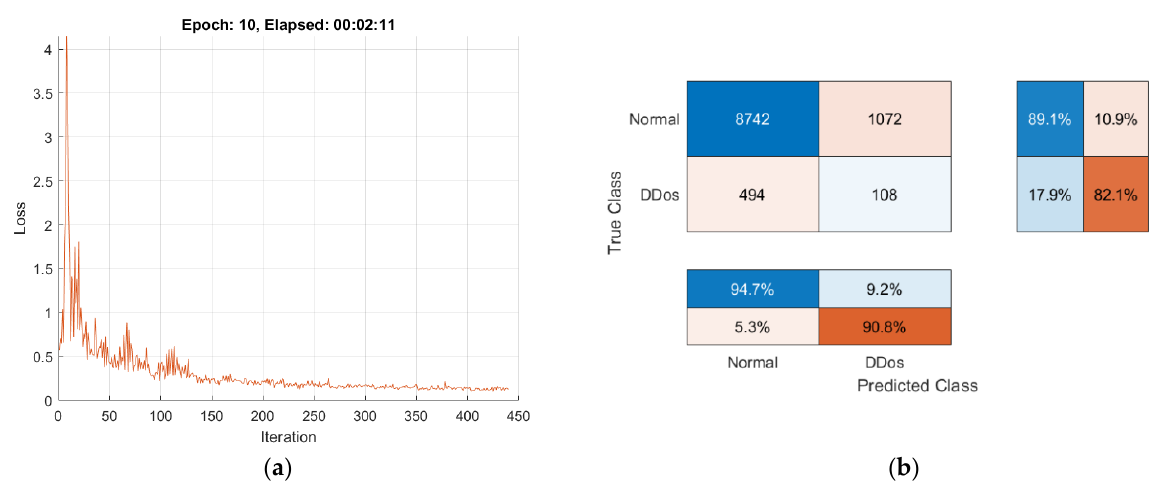
( b ) confusion matrix of Local Model2.